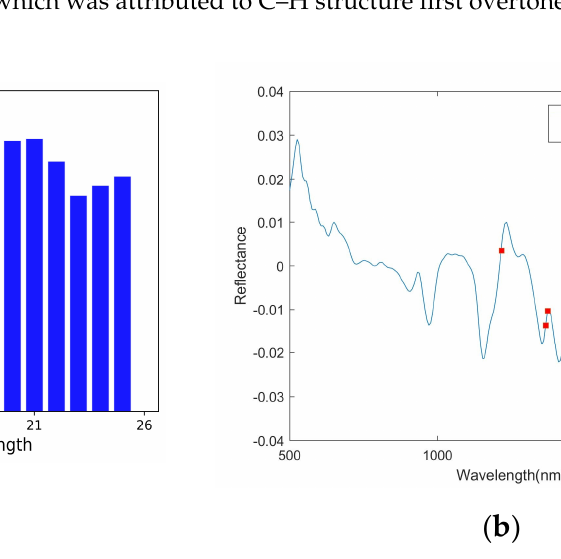
Figure 6. Results of the fine selection wavelengths by CARS-GDI algorithm. ( a ) The eigenvalues of each wavelength calculated by GDI. ( b ) Selected characteristic wavelengths by GDI.